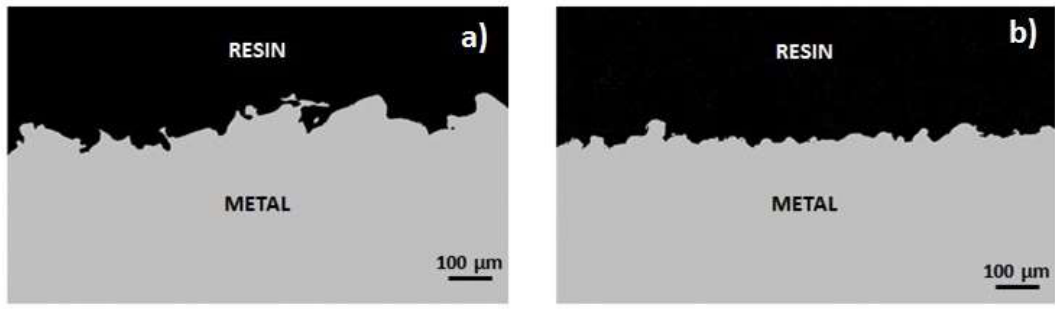
Figure 6. Morphological profile of ( a ) as-produced EBM and ( b ) as-produced DMLS samples.